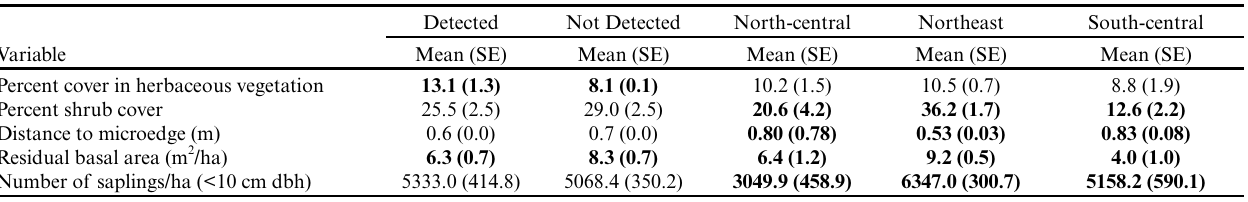
Table 4 . Comparison of within-stand metrics in regenerating stands where Golden-winged Warblers ( Vermivora chrysoptera ) were (n = 47) and were not (n = 69) detected during point-count surveys across the mid-Appalachian and within the north-central (n = 34), northeast (n = 62), and south-central (n = 20; 2010-2011) regions. Bold text indicates within-stand features that differed significantly (P < 0.05) in post hoc univariate